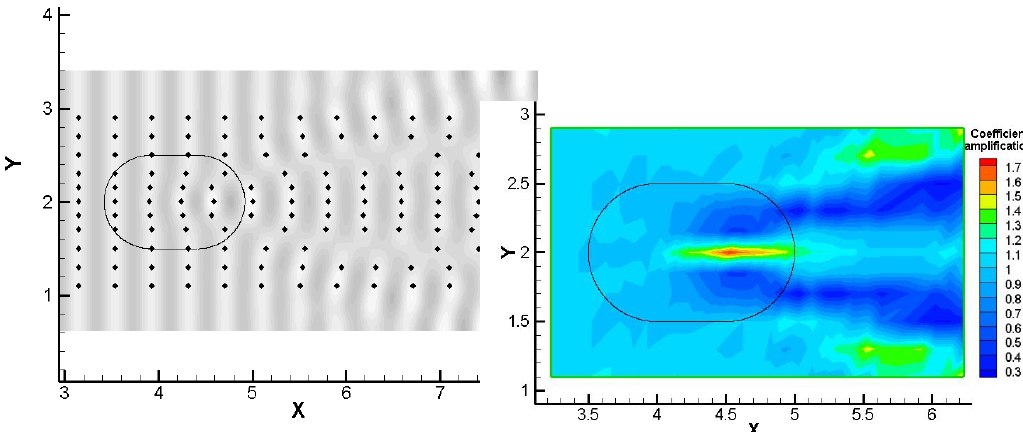
Fig. 9: Wave phase (left) and amplitude (right) measurements, T=0.5s Fig. 9. Wave phase (left) and amplitude (right) measurements, T = 0 .